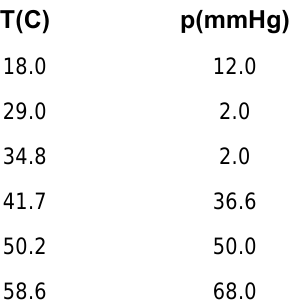
Vapor Pressure of DPhTOx at Different Temperatures, Measured via a Bodestein Differential